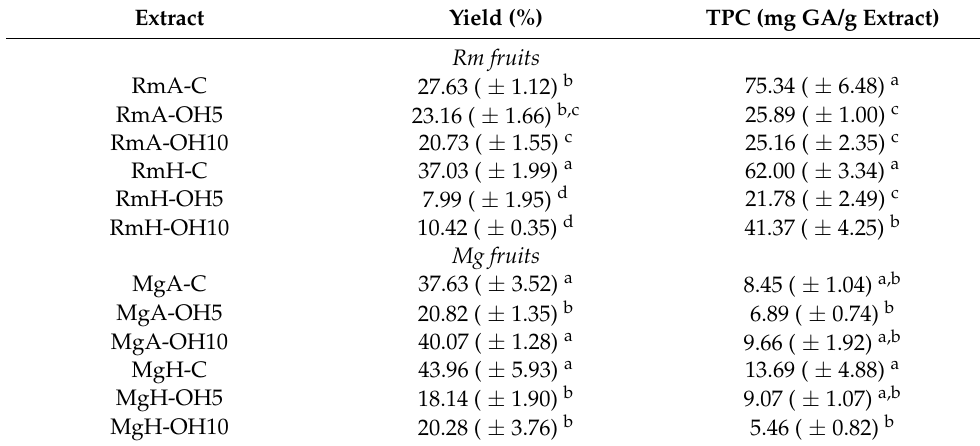
Table 1. Yields (%) and total phenolic content (TPC) of R. microphylla (Rm) and M. geometrizans (Mg) fruit extracts obtained by conventional agitation (C) and ohmic heating (OH).